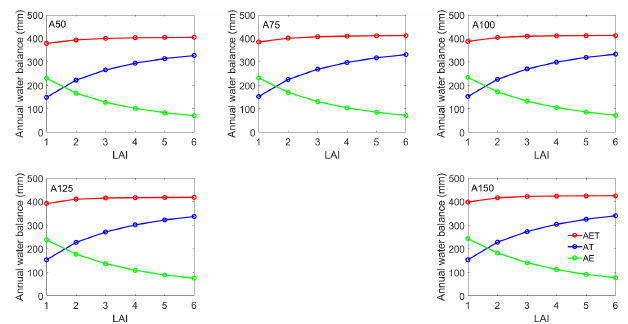
Figure A5. Partition of AET into AT and AE with the variation of LAI for the five illustrative covers.